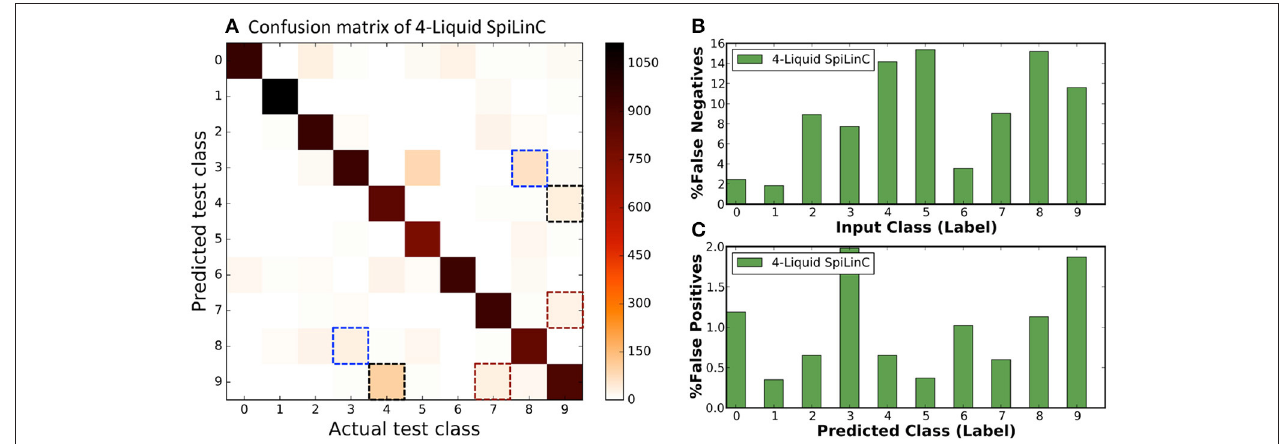
FIGURE 8 | (A) Confusion matrix of four-liquid SpiLinC with 3,200 neurons per liquid trained on 64,000 MNIST training examples. (B) Percentage of false negatives predicted by the four-liquid SpiLinC for every input class. (C) Percentage of false positives produced by the four-liquid SpiLinC for every predicted